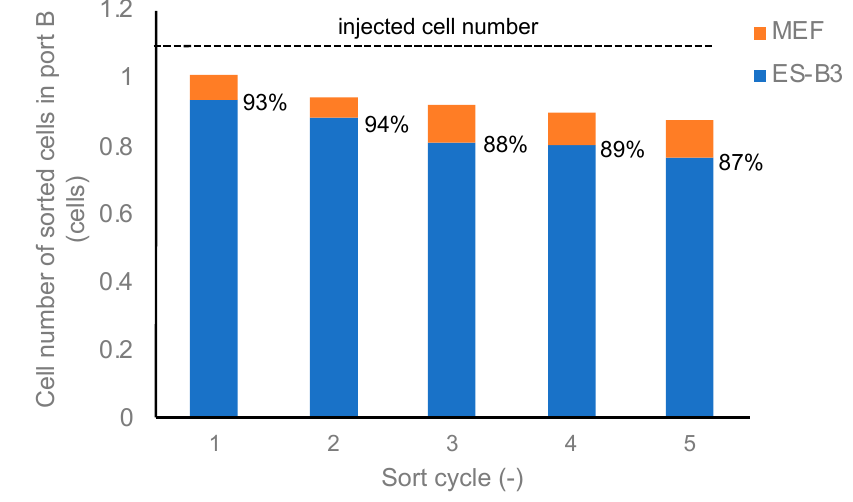
Figure 9. Purification ratio of ES-B3 cells in the sorted-cell suspension and total cell loss compared to the injected cell number.